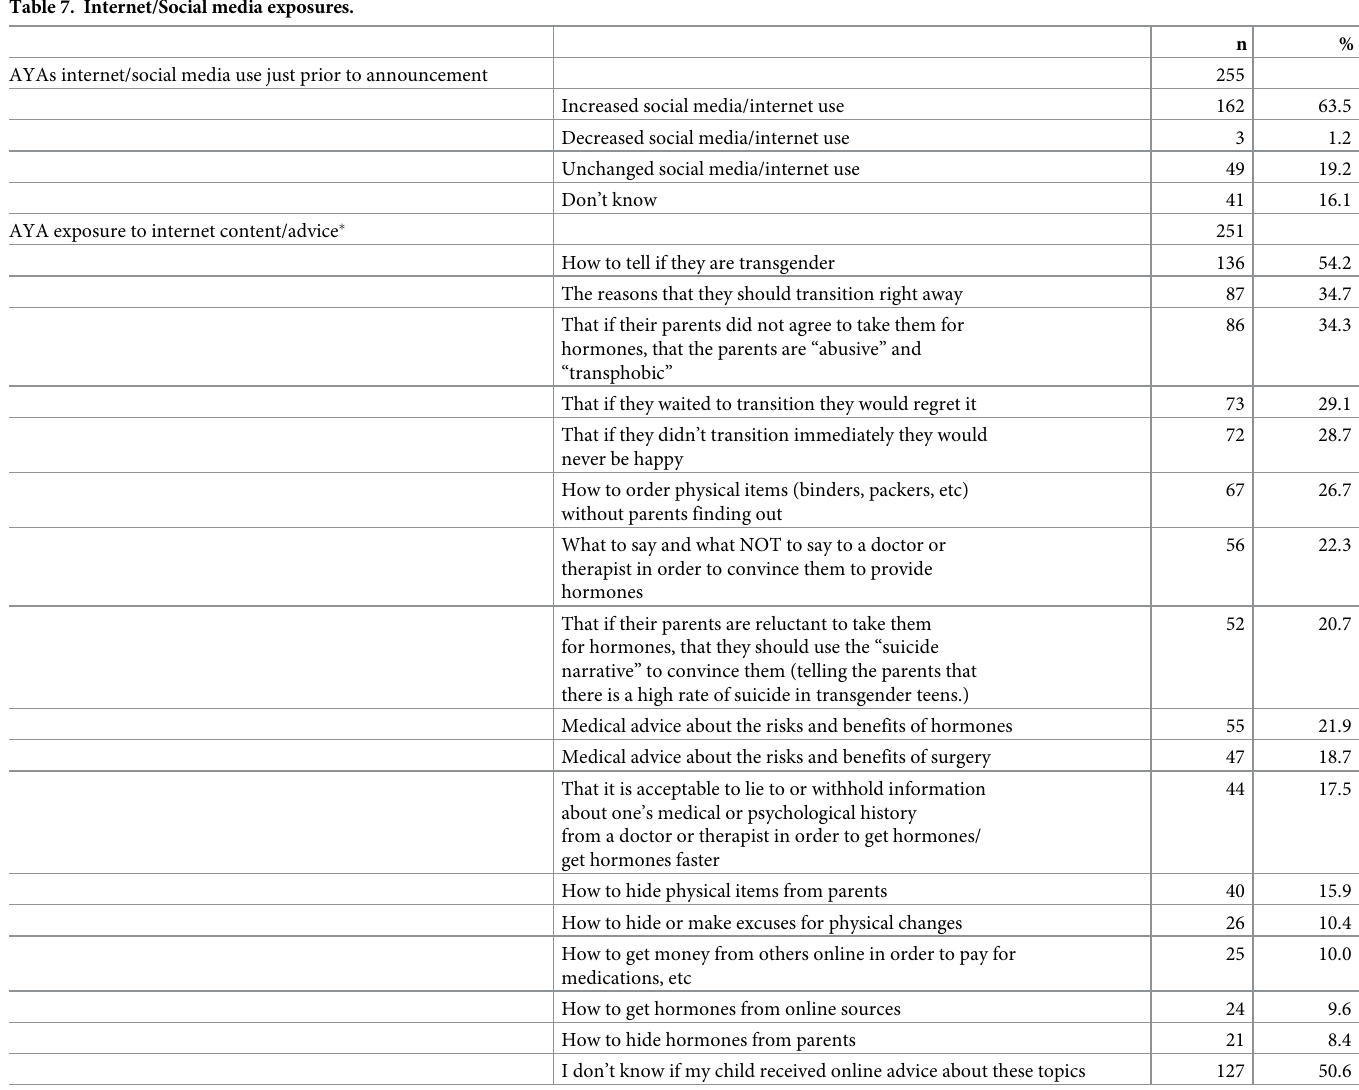
Table 7. Internet/Social media